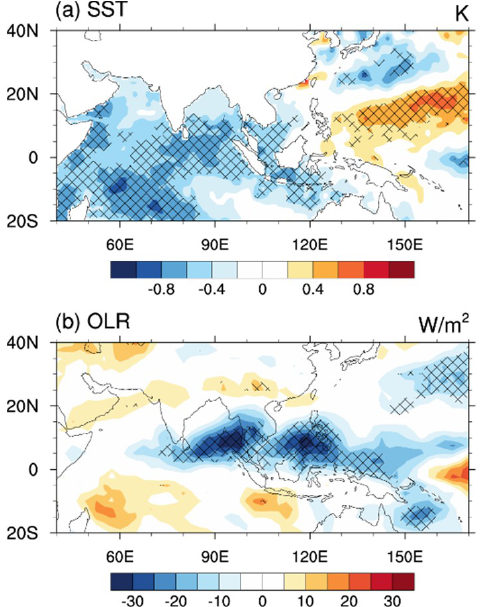
Figure 7. Composite differences of ( a ) SST anomalies (shading; K) and ( b ) OLR anomalies (shading; W/m 2 ) in April between the North and South track cases. Cross hatching indicates the anomalies exceeding the 0.05 significance level.